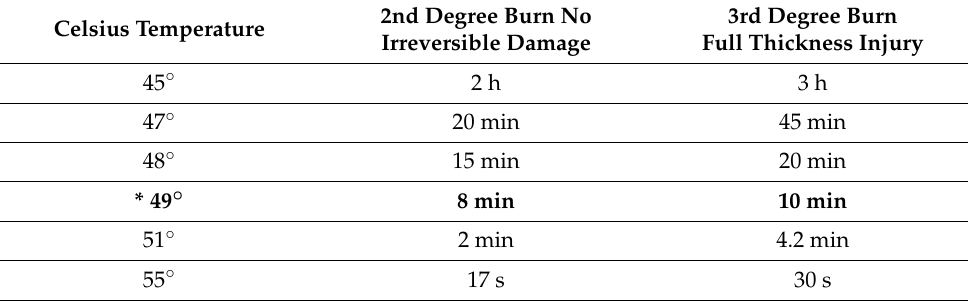
Table 3. Time and Temperature Relationship to Extreme e